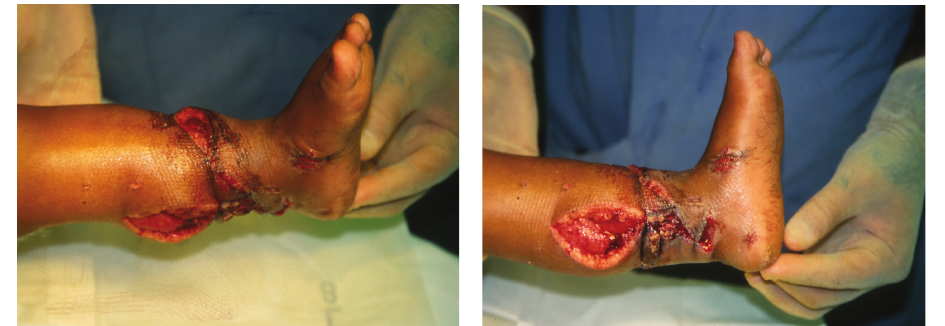
Figure 2: Postoperative.